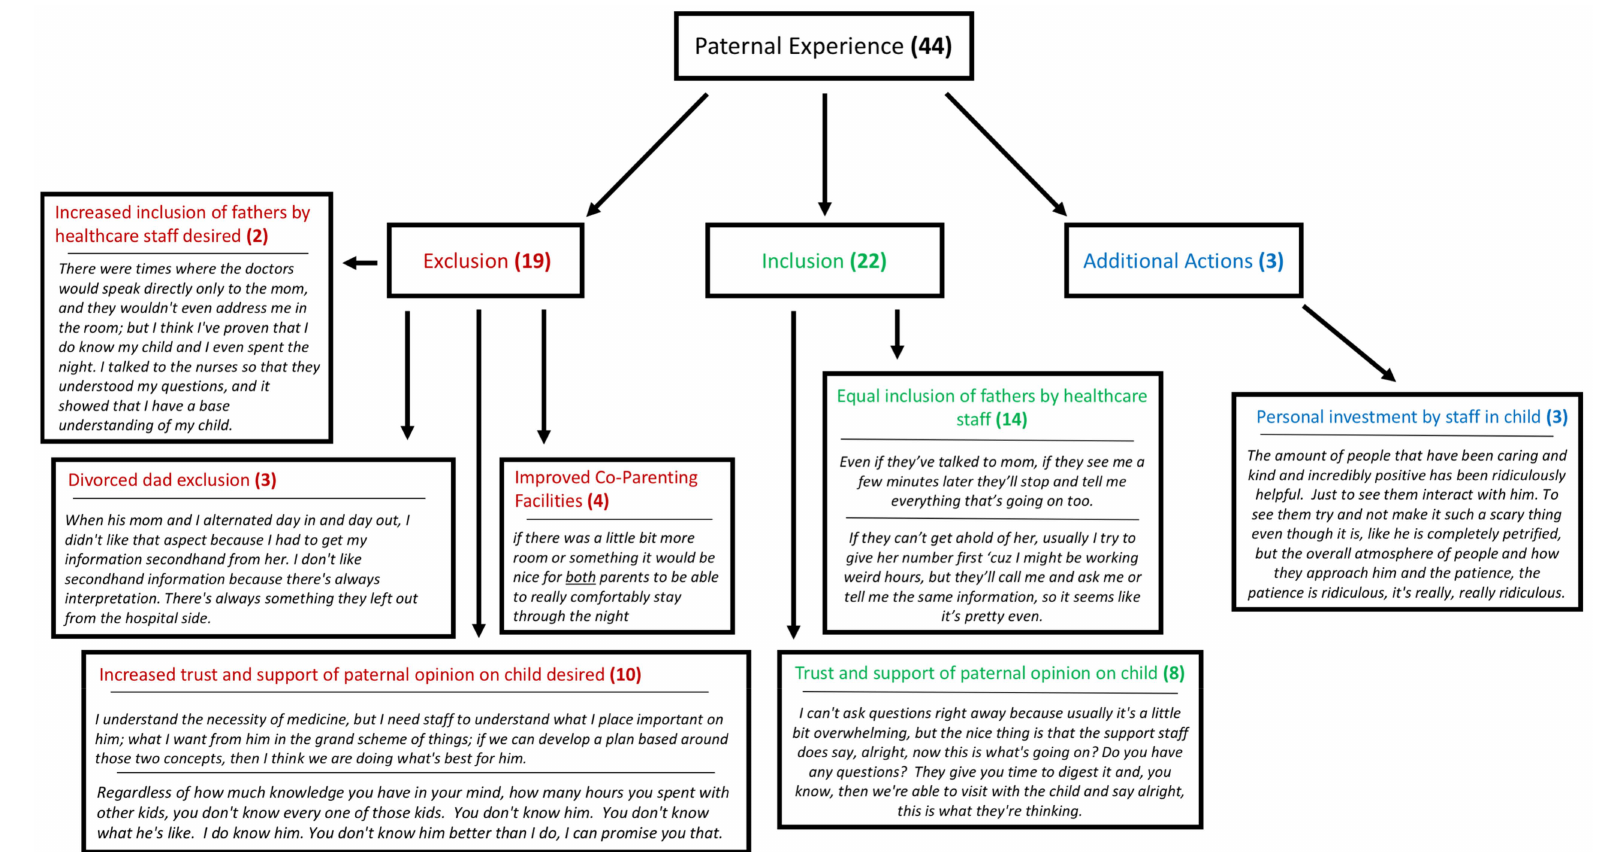
Figure 1. Flow chart depicting the paternal experience within the healthcare setting categorized into exclusion, inclusion, and additional actions. The bolded number represents the amount of extracted codes identified to match the respective theme, and the italics below each theme are specific quotations taken from paternal